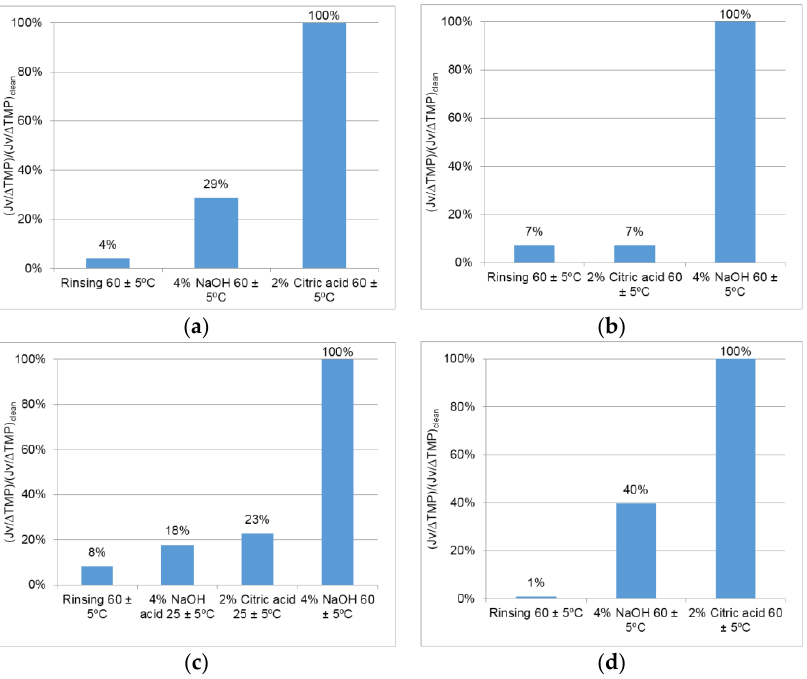
Figure 4. Percent recovery of the permeate flux per transmembrane pressure applied ( J v /Δ TMP )/( J v /Δ TMP ) clean with different cleaning protocols performed after the membrane filtration assays: ( a ) test 1; ( b ) test 2; ( c ) test 3; ( d ) test 4.